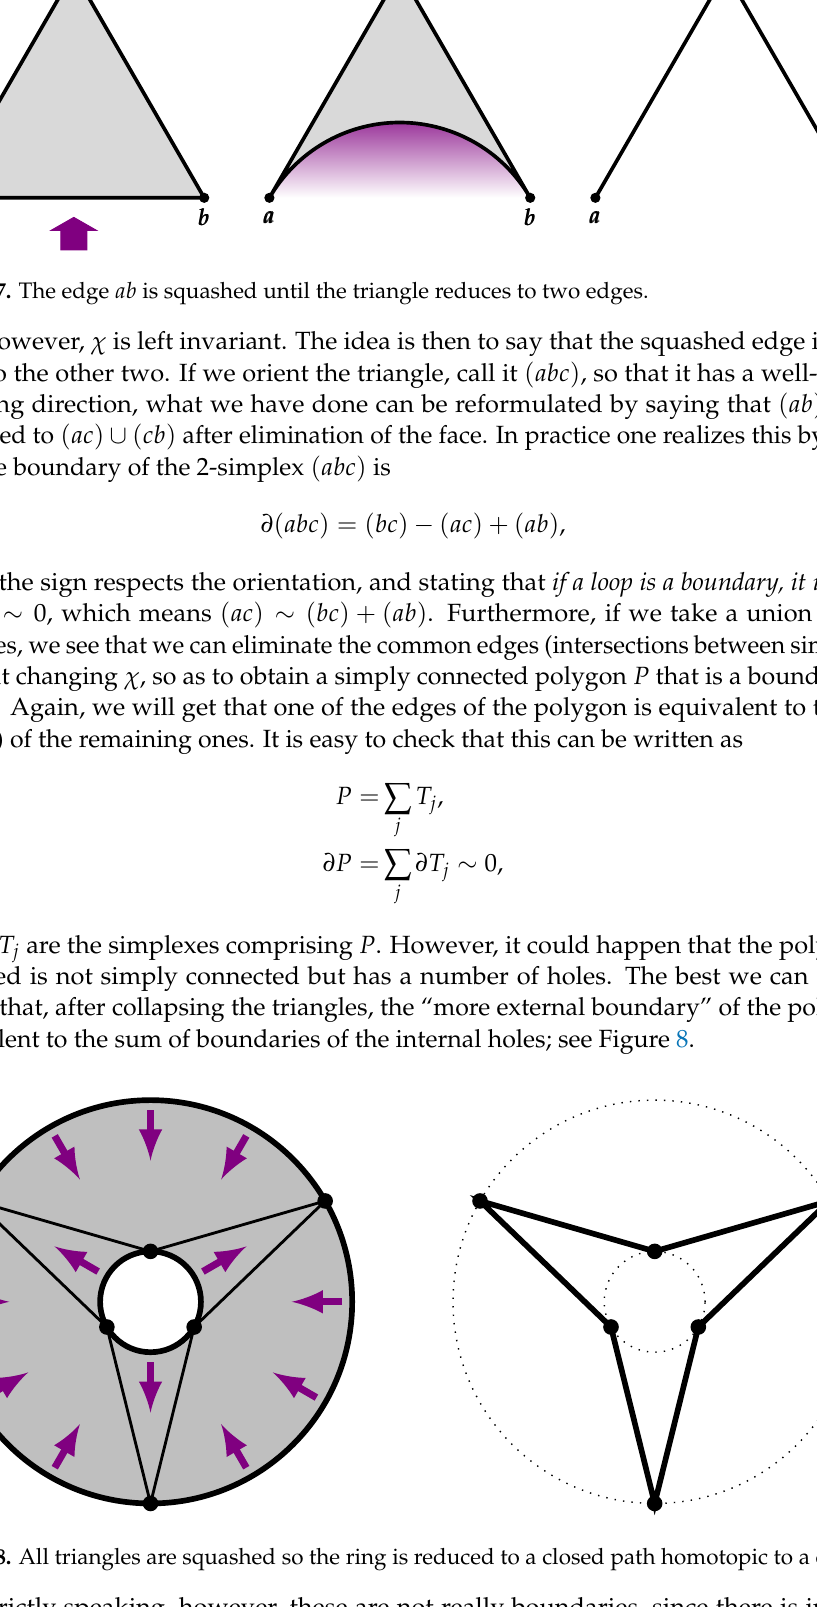
Figure 7. The edge ab is squashed until the triangle reduces to two edges.